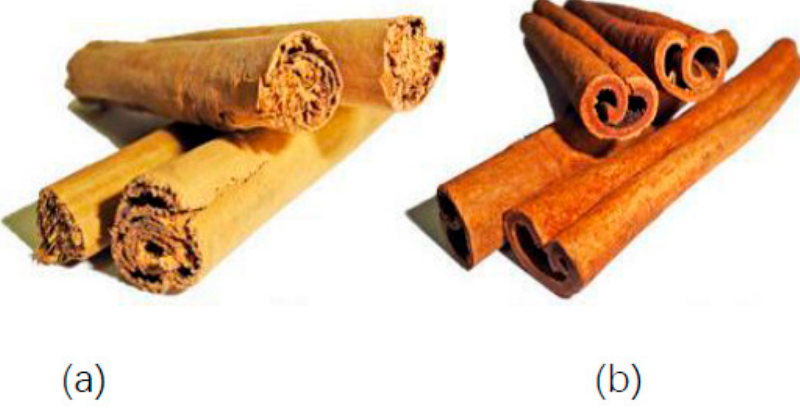
Figure 3. Cinnamon bark ( a ) C. verum J. Presl and ( b ) C. cassia L. Source: [80] . The medicinal and spicy properties of C. verum J. Presl cinnamon bark result mainly from its composition. In addition, Ceylon cinnamon is more expensive due to its chemical composition, high quality, health benefits, and trace amounts of coumarin, which is found in higher concentrations in Cassia cinnamon. Table 3 shows the bark composition of two popular cinnamon trees. Table 3. Basic composition of the bark of Cinnamomum verum J. Presl and Cinnamomum cassia L. Cinnamon